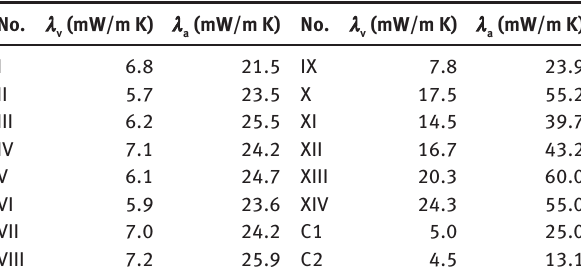
Table 7 Core samples and thermal conductivity coefficients of VIPs produced by these sample.